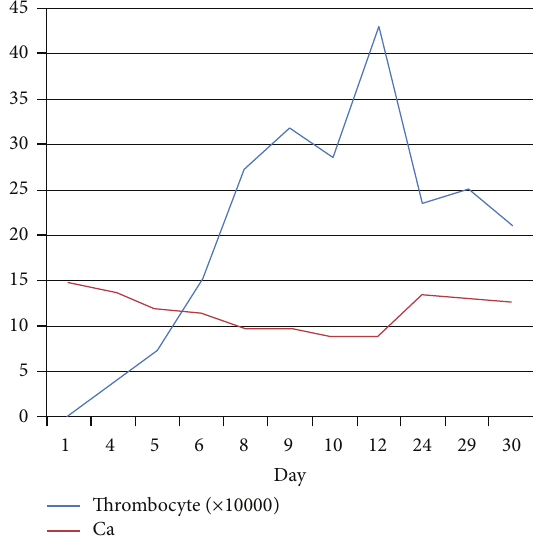
Figure 2: After treatment, relationship with calcium and thrombo- cyte